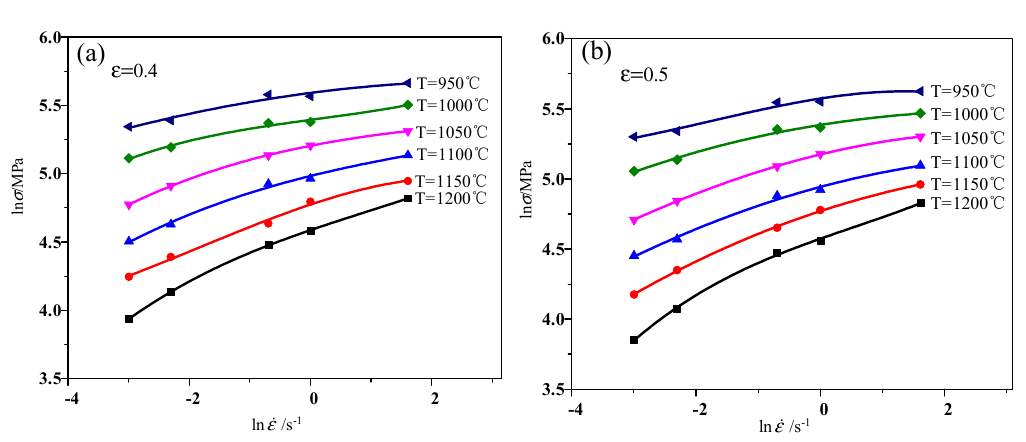
Figure 6. Cubic spline curve fitting of ln σ and ln ε at different temperatures: ( a ) ε = 0.4; ( b ) ε = 0.5. According to Formulas (7) and (8), strain rate sensitivity coefficient m is calculated. By substituting m values into Formula (6), the power dissipation coefficient can be obtained. As shown in Figure 7, the maximum dissipation coefficient is 0.34 when the strain is 0.2. When the strain is up to 0.5, the maximum value of the dissipation coefficient is 0.49. It can be seen that as the amount of deformation increases, the dissipation coefficient shows an increasing trend.